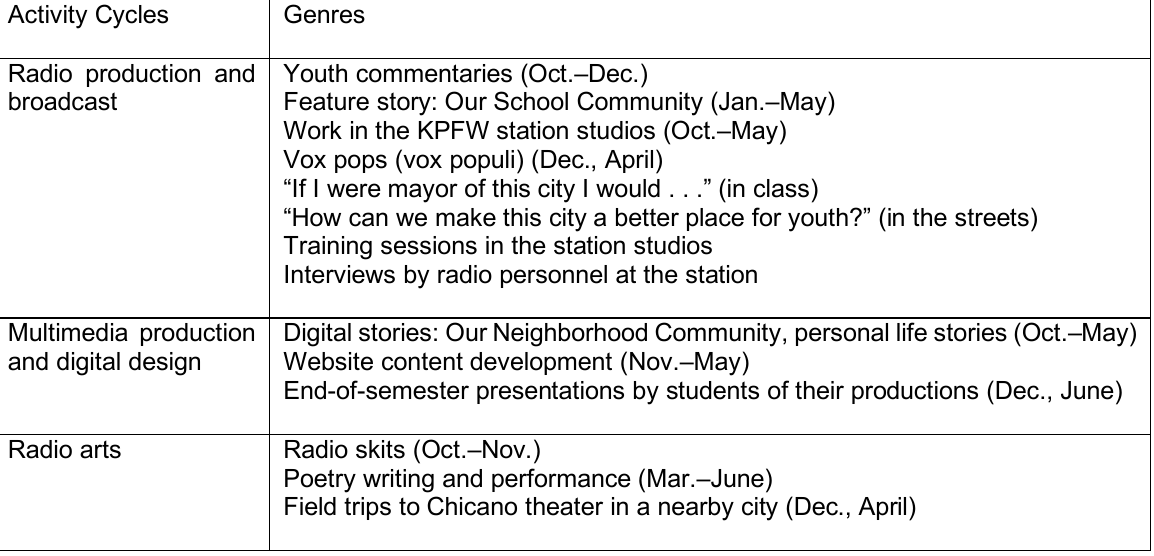
Table 1. Activity Cycles and